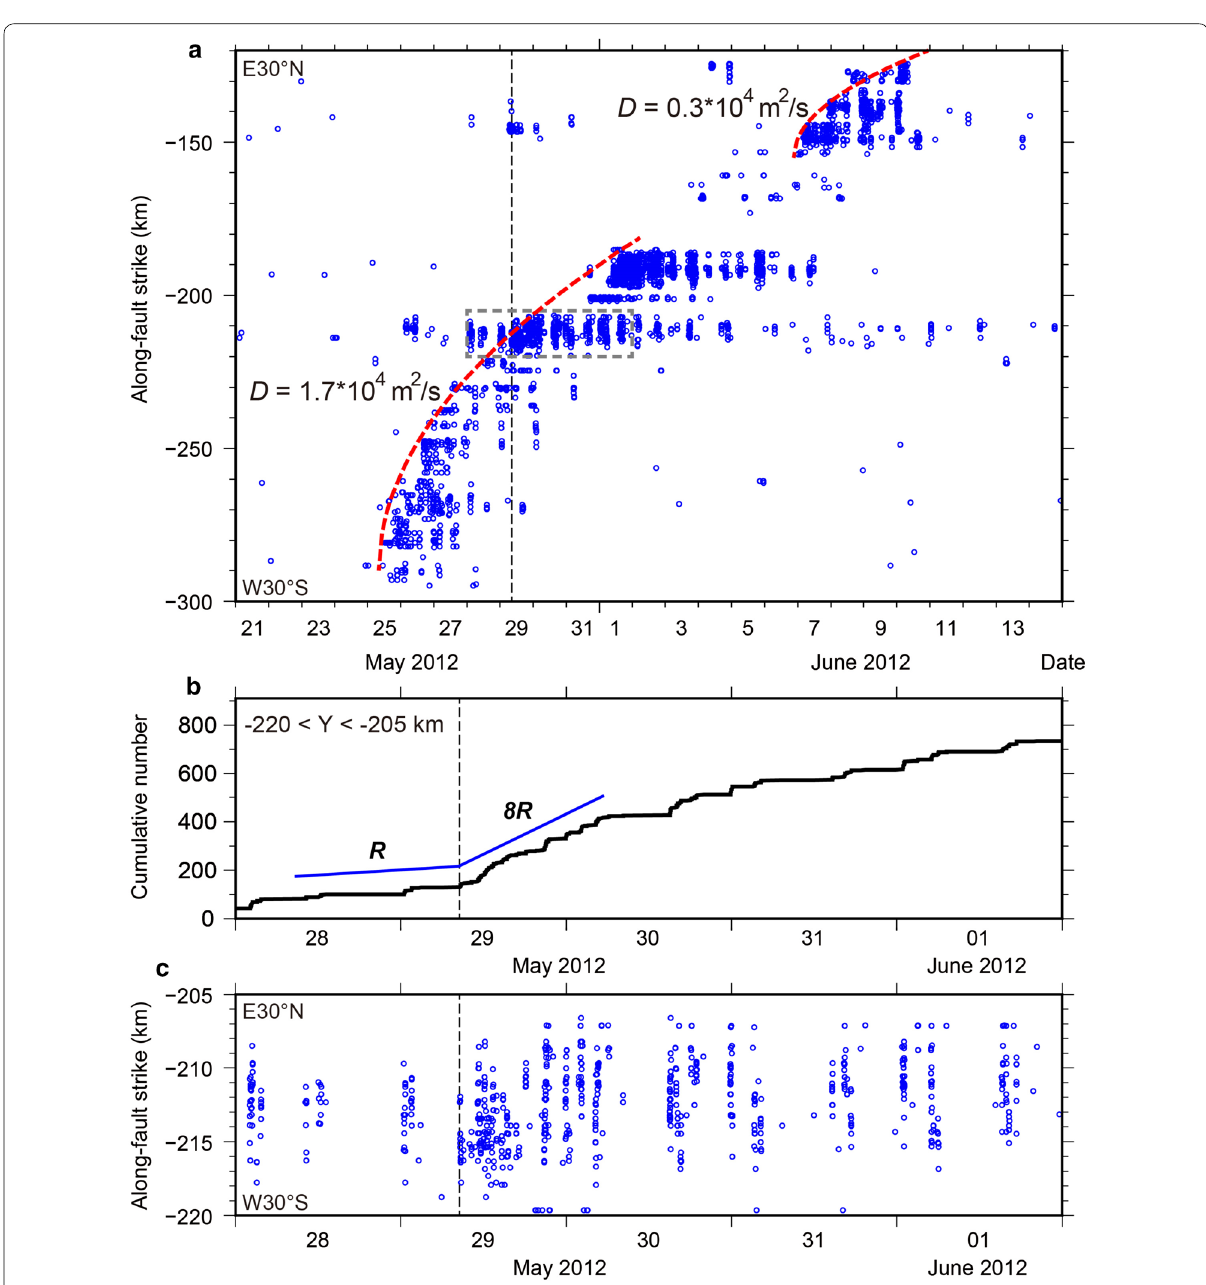
Fig. 3 An example of slow long-distance migration of LFEs during an ETS episode. a Space–time diagram of detected LFEs as a function of distance along fault strike (blue circles). Dashed red curves show diffusional fronts assuming the diffusion coefficients shown in the figure. The gray dotted-line rectangle represents the box of b . b Time series of the cumulative number of LFEs within the gray dotted-line box in a ( 220 < Y < 205). The vertical dashed line coincides with the timing at which the migrating front of LFEs passes. “R” indicates the LFE occurrence − − rate before the migration front passes. c A zoomed-in view of the gray dotted-line box in